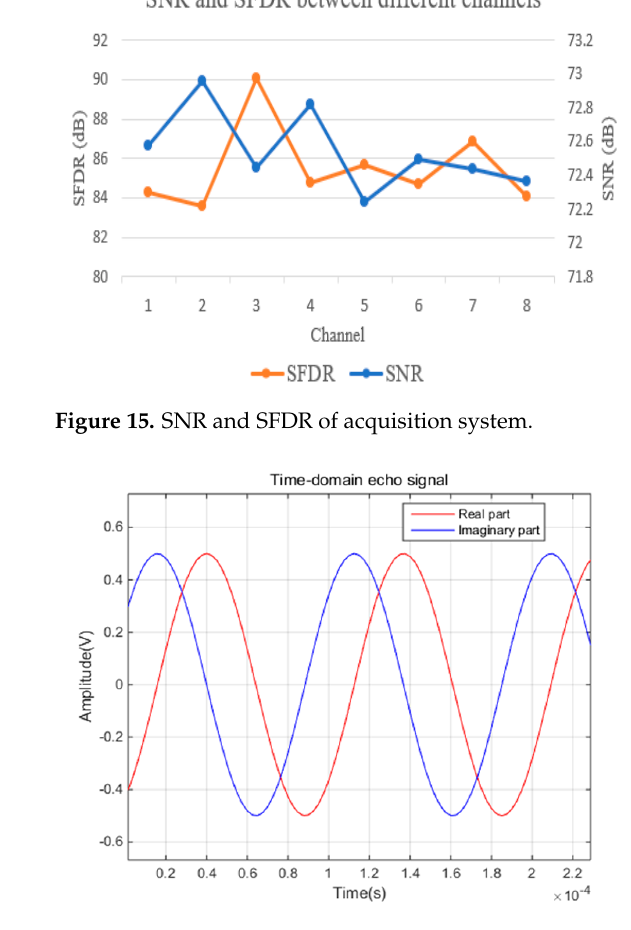
Figure 16. Waveform of echo signal.